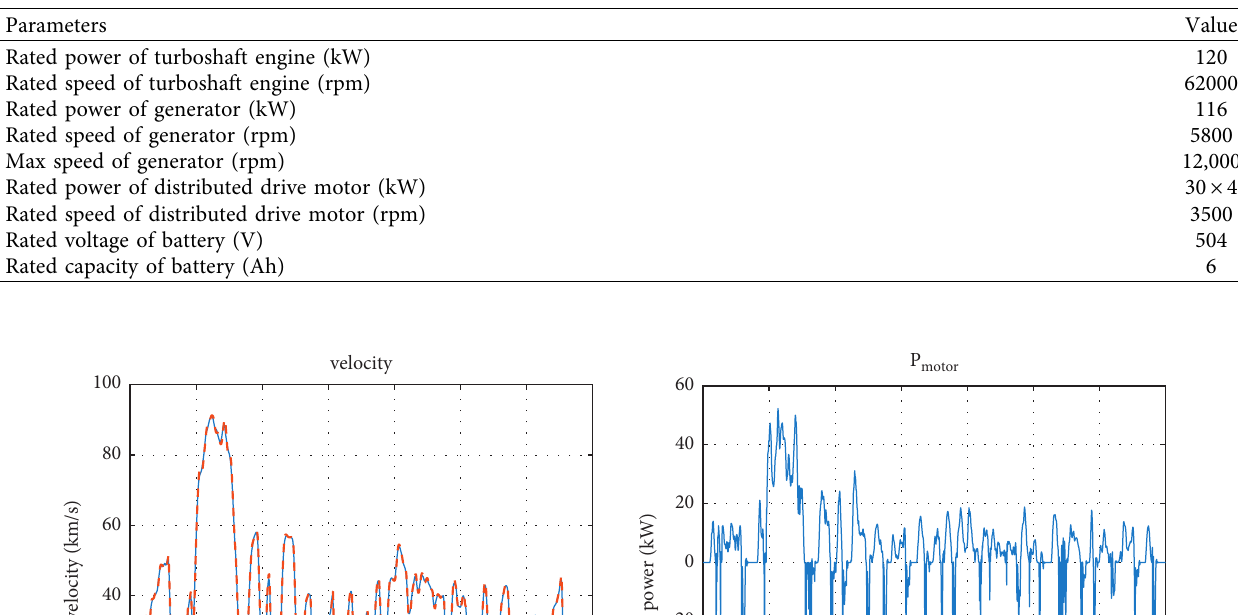
Table 4: Main parameters of HPU.